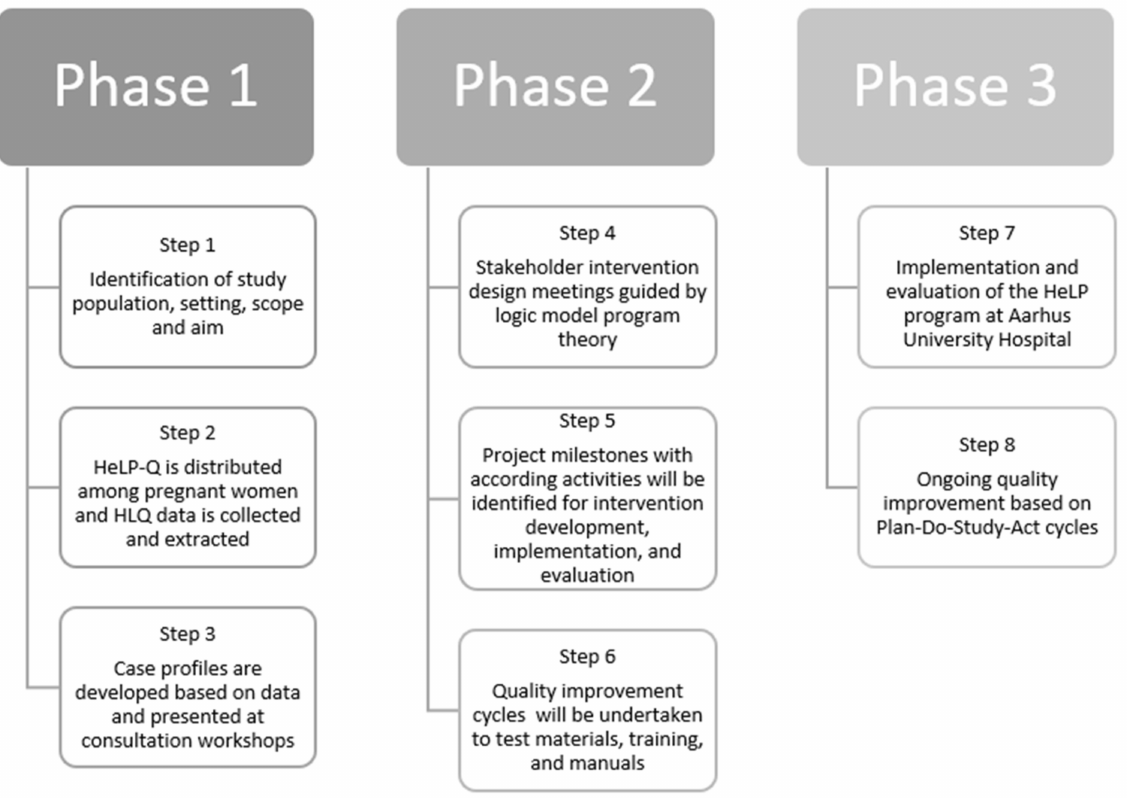
Figure 2. The Ophelia process—three phases and according steps in the HeLP